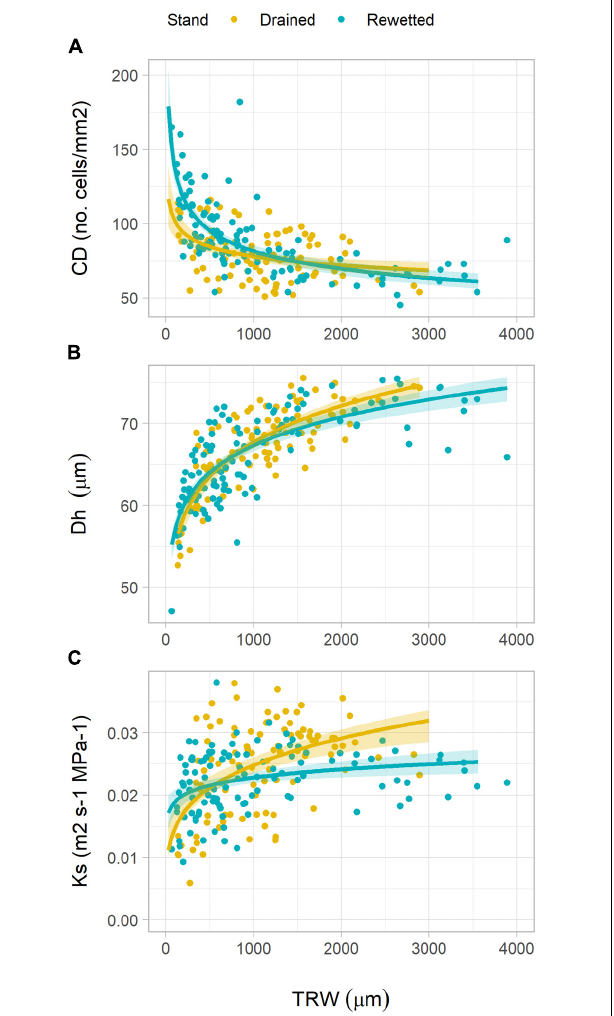
FIGURE 5 | Relationship between tree-ring width (TRW) and (A) vessel density (CD), (B) hydraulically weighted mean vessel diameter (Dh), and (C) xylem-specific hydraulic conductivity at ring level (Ks) in both stands. Lines show regression fits and shadows indicate the 95% confidence interval of the model fit (refer to Table 2 for regression